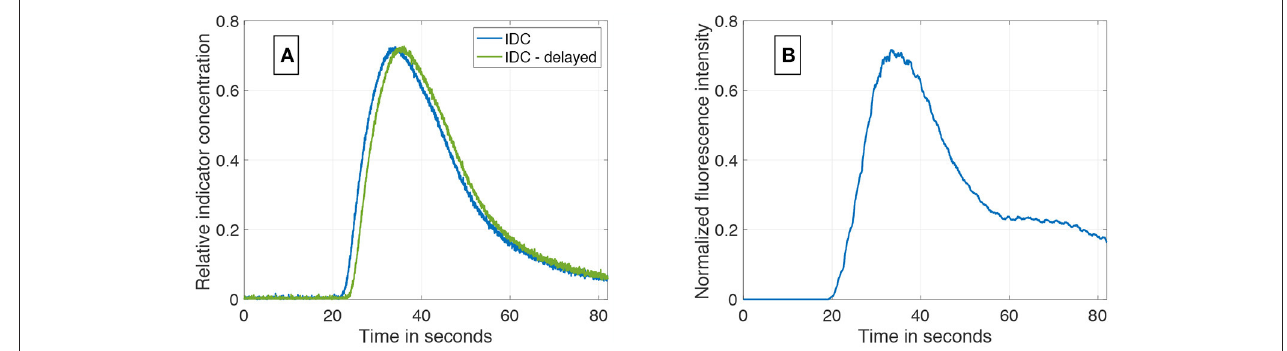
FIGURE 6 | (A) An example of a synthetically computed data set. It shows two indicator dilution curves with an delay of 1.5 s and a SNR of 37 dB . (B) An in vivo indicator dilution curve obtained from a cerebrovascular EC-IC bypass surgery by indocyanine green fluorescence angiography. The signal is obtained by averaging an area of 10 10 pixel which corresponds to one-third of the vessel’s diameter. ×